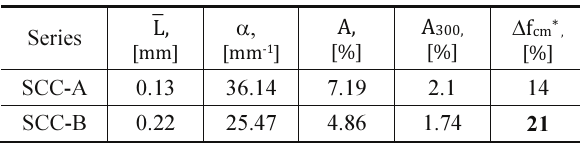
Table 6 . The values of non entrained concrete porosity structure